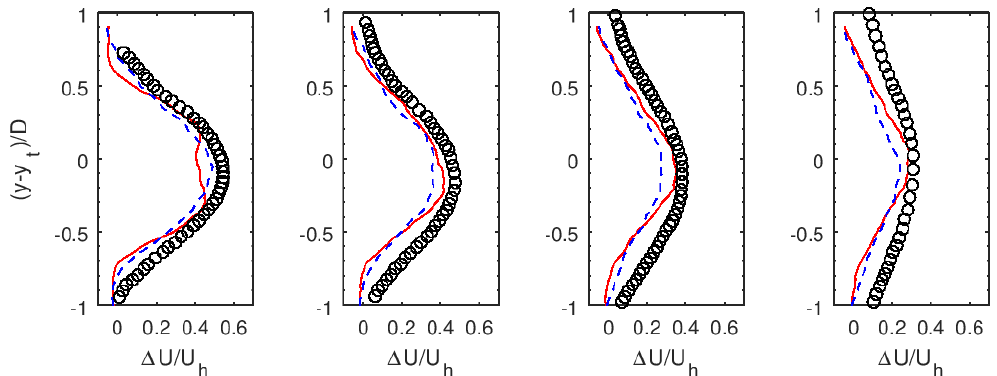
Figure 4. Comparison of the simulated velocity deficit profiles with measurements at the SWiFT site. The measured data are digitized from [33]. Details on the measurements can be found in [34]. Red lines: T80; Blue lines: T27; Circles: measurements.